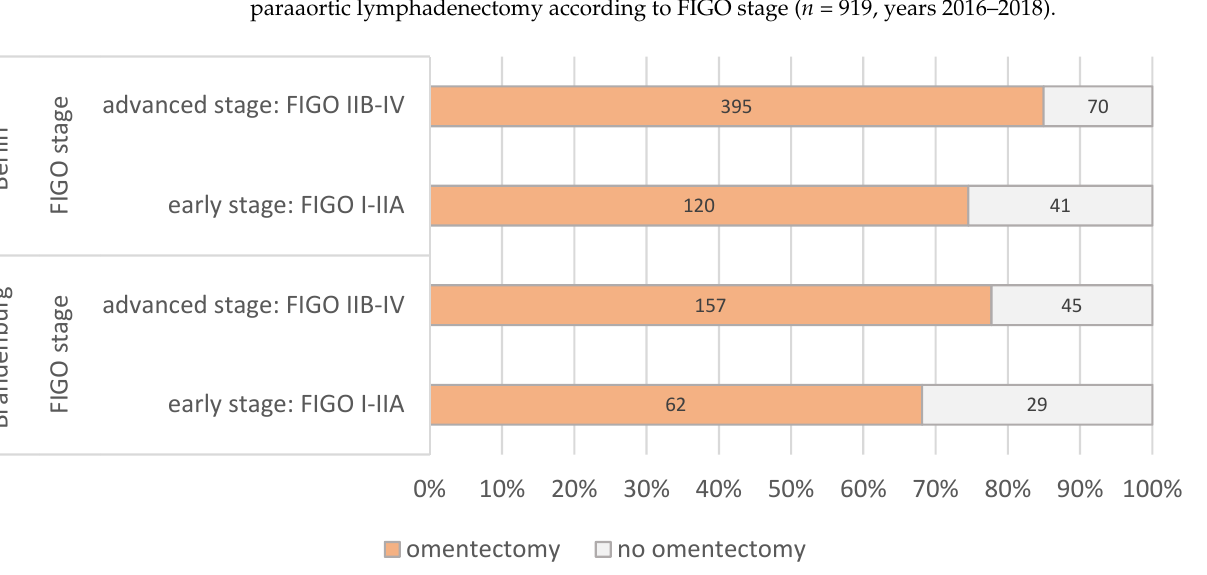
Figure 4. Proportion of patients with primary ovarian cancer with and without omentectomy according to FIGO stage ( n = 919, years 2016–2018).